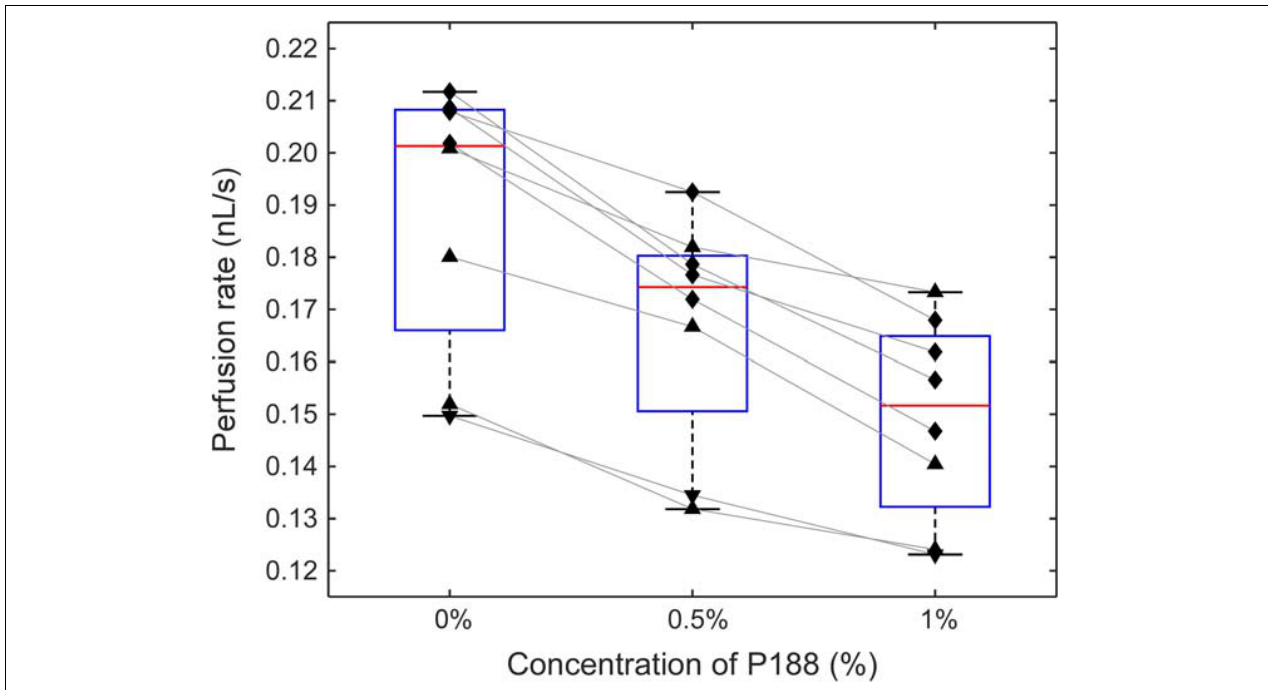
FIGURE 4 | The effect of incubation of sickle RBCs with P188 at a concentration of 0 (control), 0.5, and 1% (w/v) on perfusion of the adhesive AMVN ( n = 8 for each condition). Triangles denote treatment with hydroxyurea, upside down triangles denote treatment with transfusion therapy, and rhombi denote treatment with both hydroxyurea and transfusion. Differences between all groups were statistically significant ( p < 0.5, paired t -test).